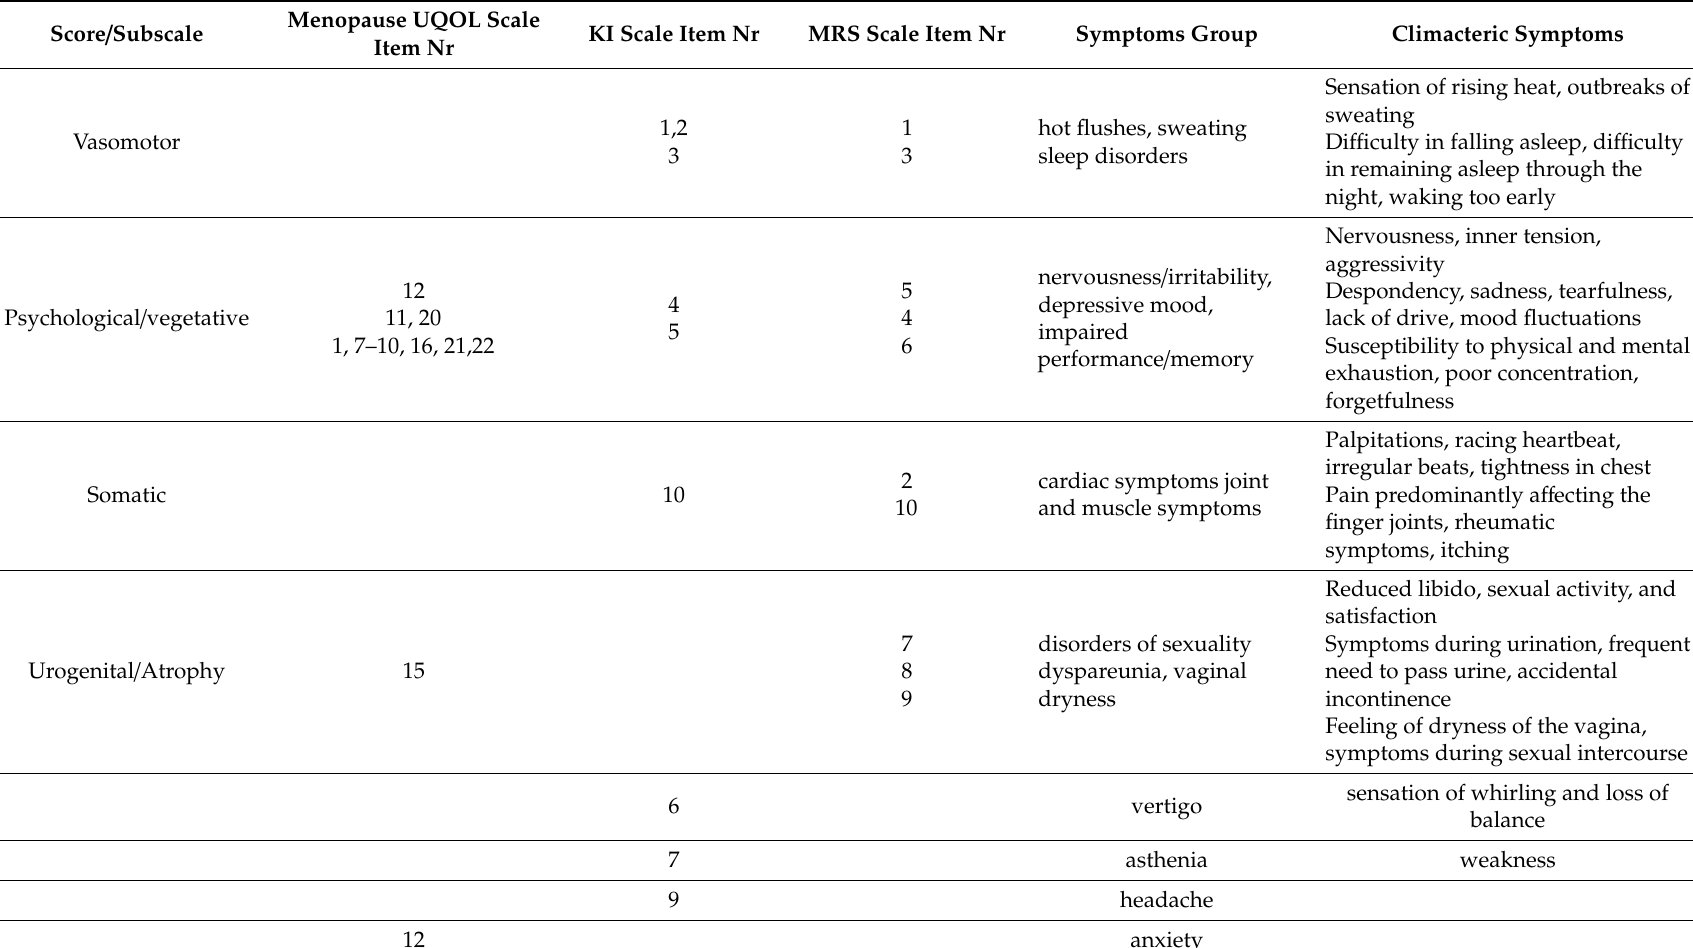
Table A1. The Menopause Syndrome-related Quality of Life MRS, KI, and UQOL rating scales, and climacteric symptoms used for assessment of e ffi cacy of BC, BC500, and RR-BC on quality of life across the full range of severity of complaints in aging women. Score /